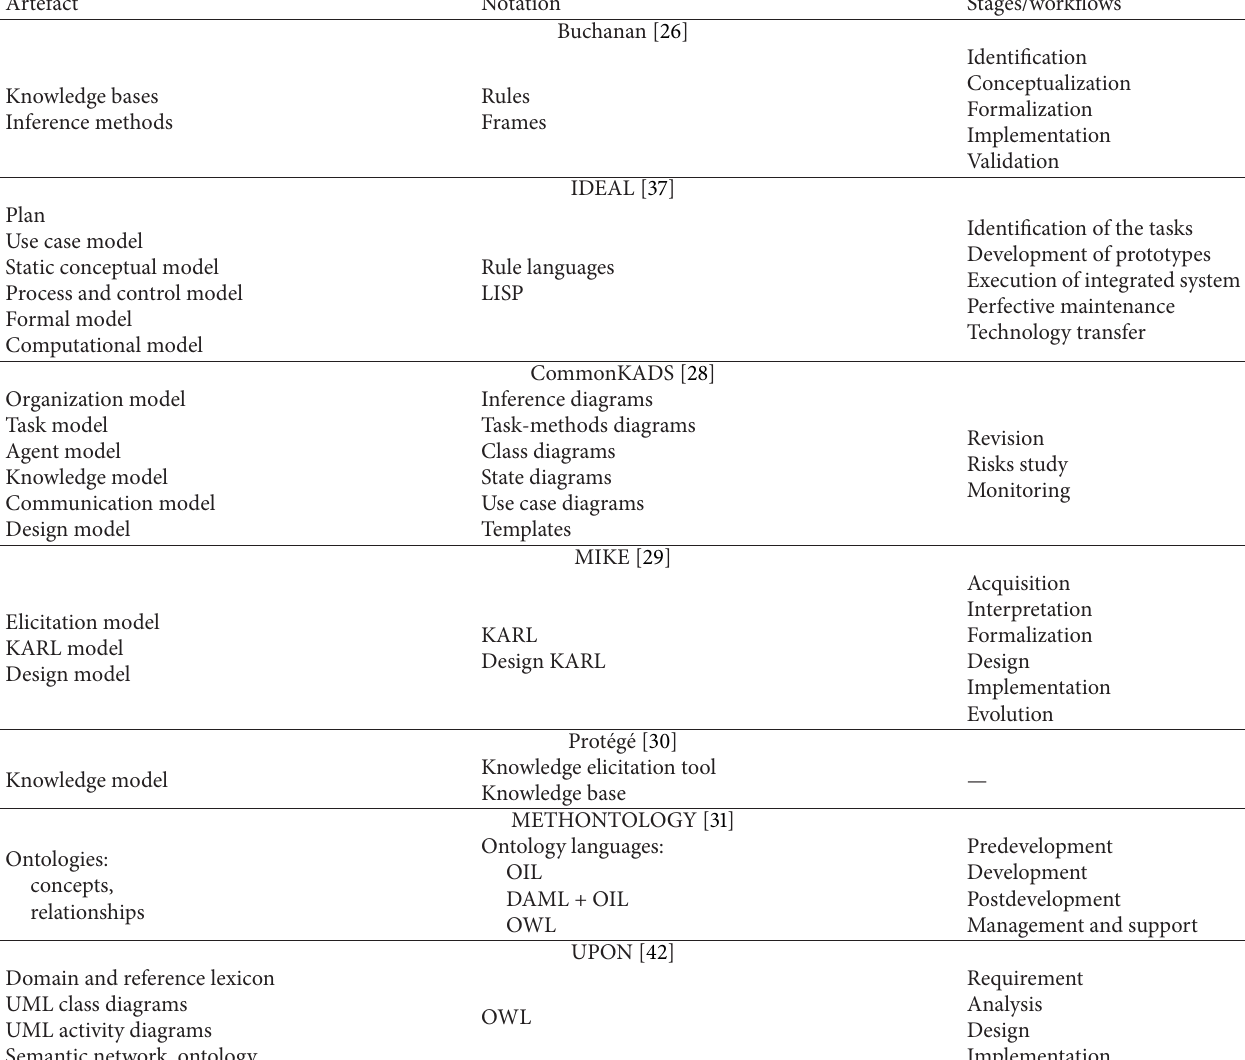
Table 4: KBS development